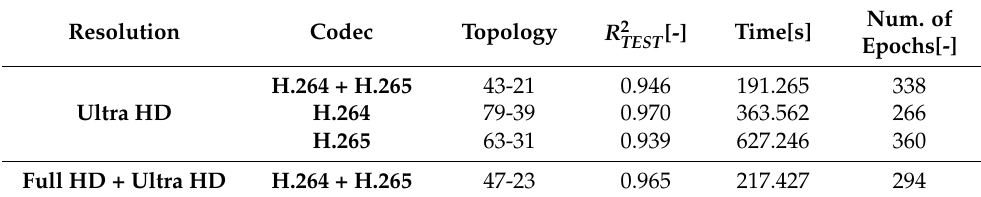
Table 7. The best topologies of bitrate prediction based on